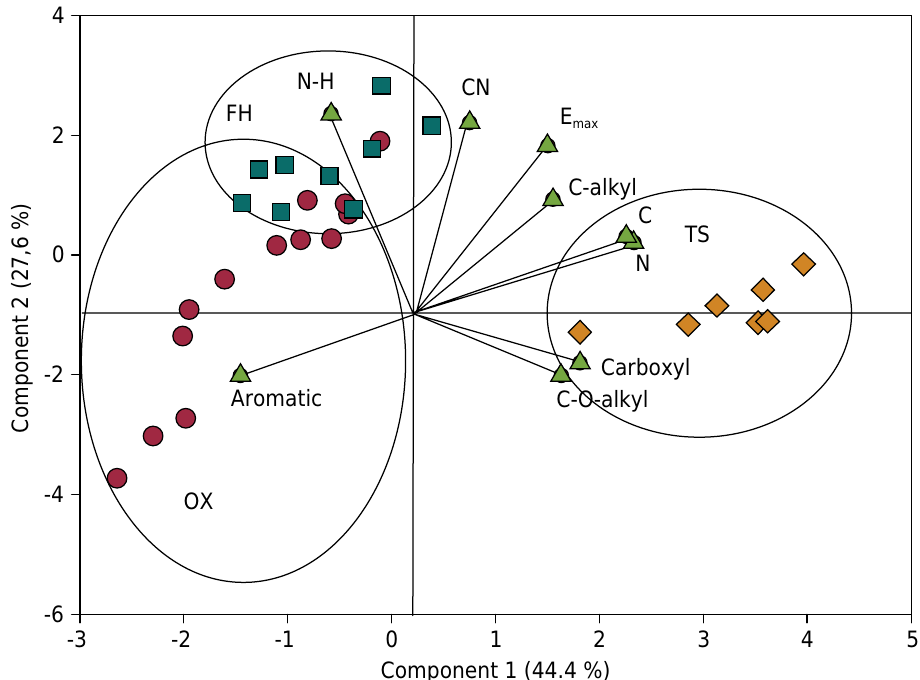
Figure 7. Dispersion diagram by principal component analysis (PCA) showing the soil classes as distinct